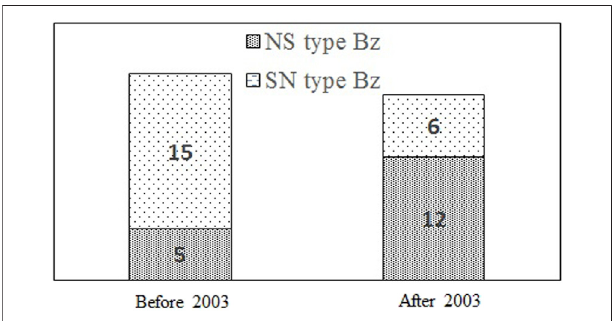
FIGURE 8 | The distribution of the Bz type of the SIMFRs with axial direction near the y direction. The left (right) histogram represents SIMFRs observed before (after)